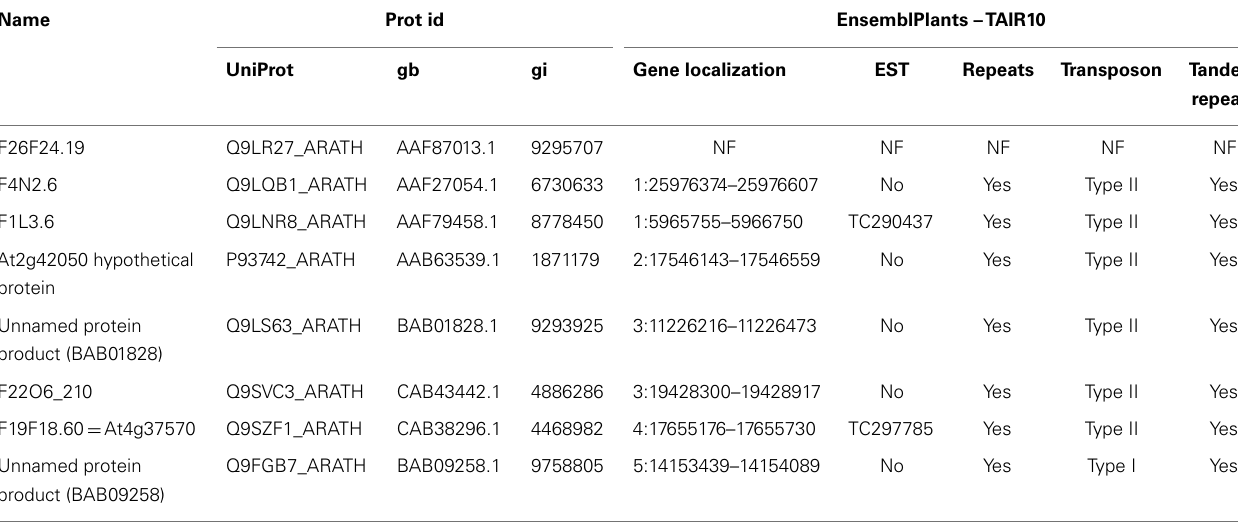
Table 1 | Identification of some putative pro-peptides and their genes in Arabidopsis thaliana